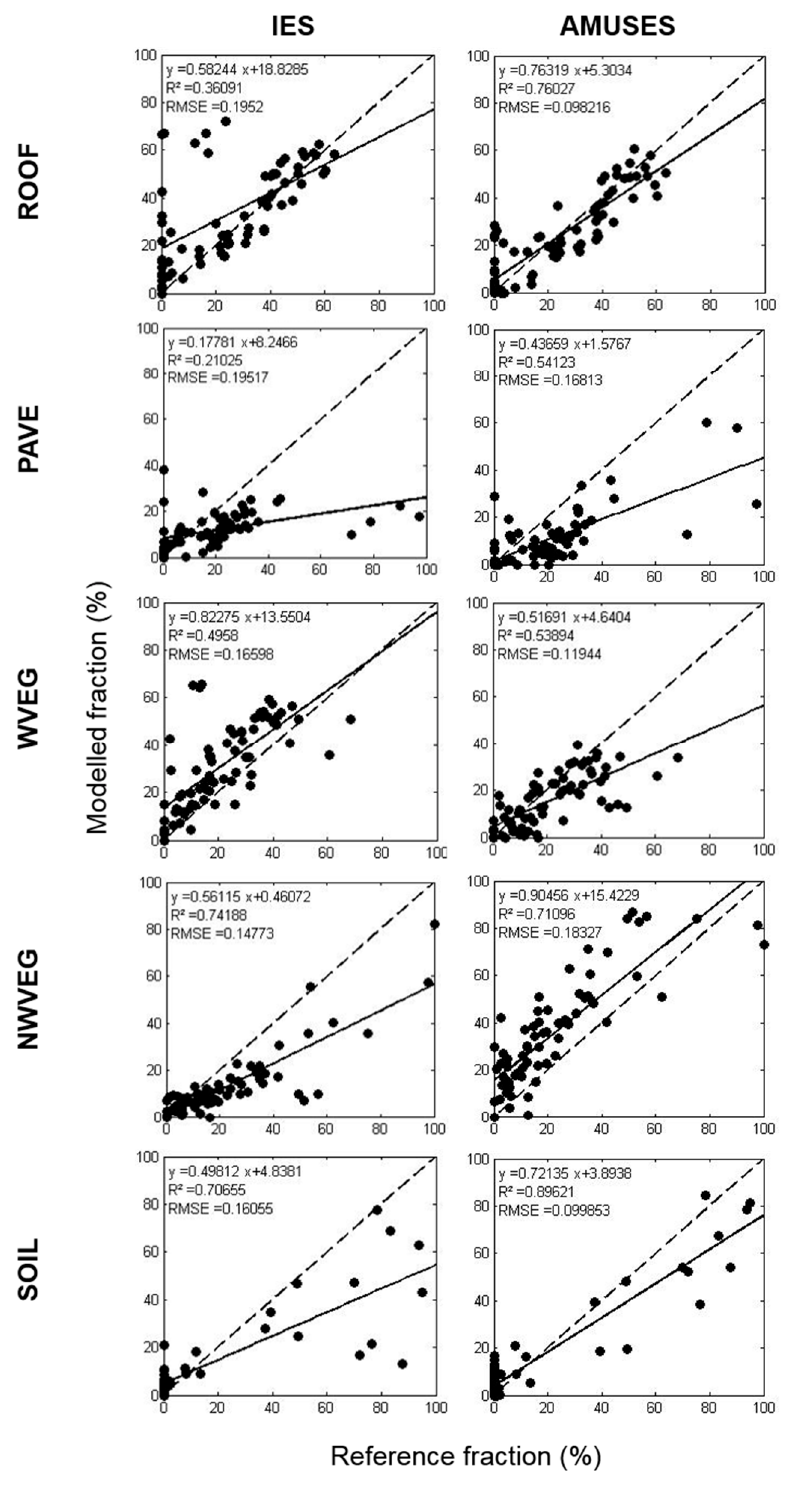
Figure 8. Comparison of reference ( x -axis) versus modelled ( y -axis) land cover fractions for 72 image blocks of the Berlin dataset. Modelled results are obtained by applying MESMA on a spectral library pruned using IES (left) and AMUSES (right). The original spectral library consisted of a mixture of Berlin and Brussels spectral libraries (experiment 3 in Table 3). PAVE = pavement; WVEG = woody vegetation; NWVEG = non-woody vegetation.